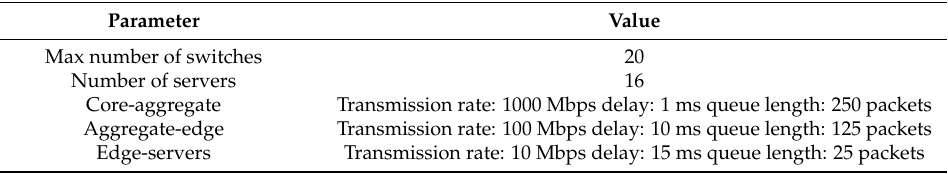
Table 6. Mininet simulation parameters.